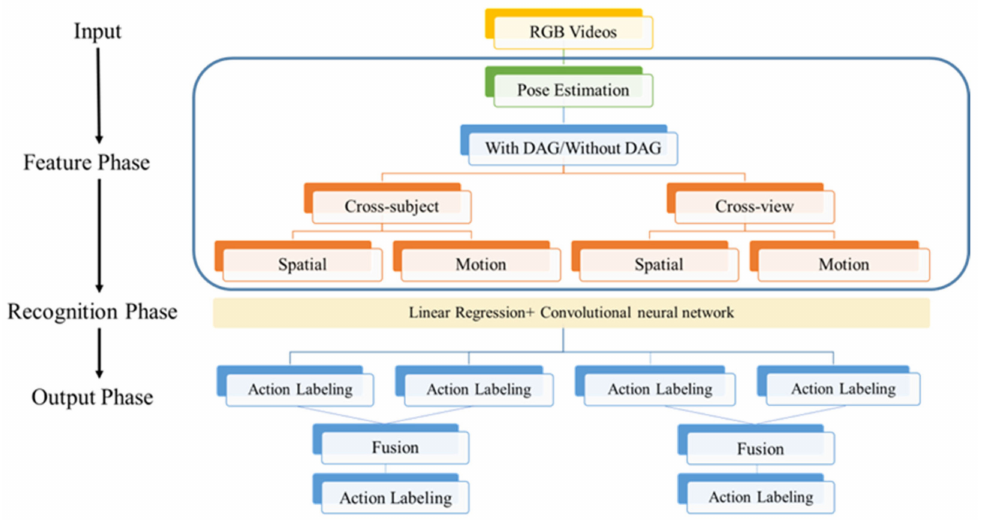
Figure 1. The flowchart of the action recognition in this